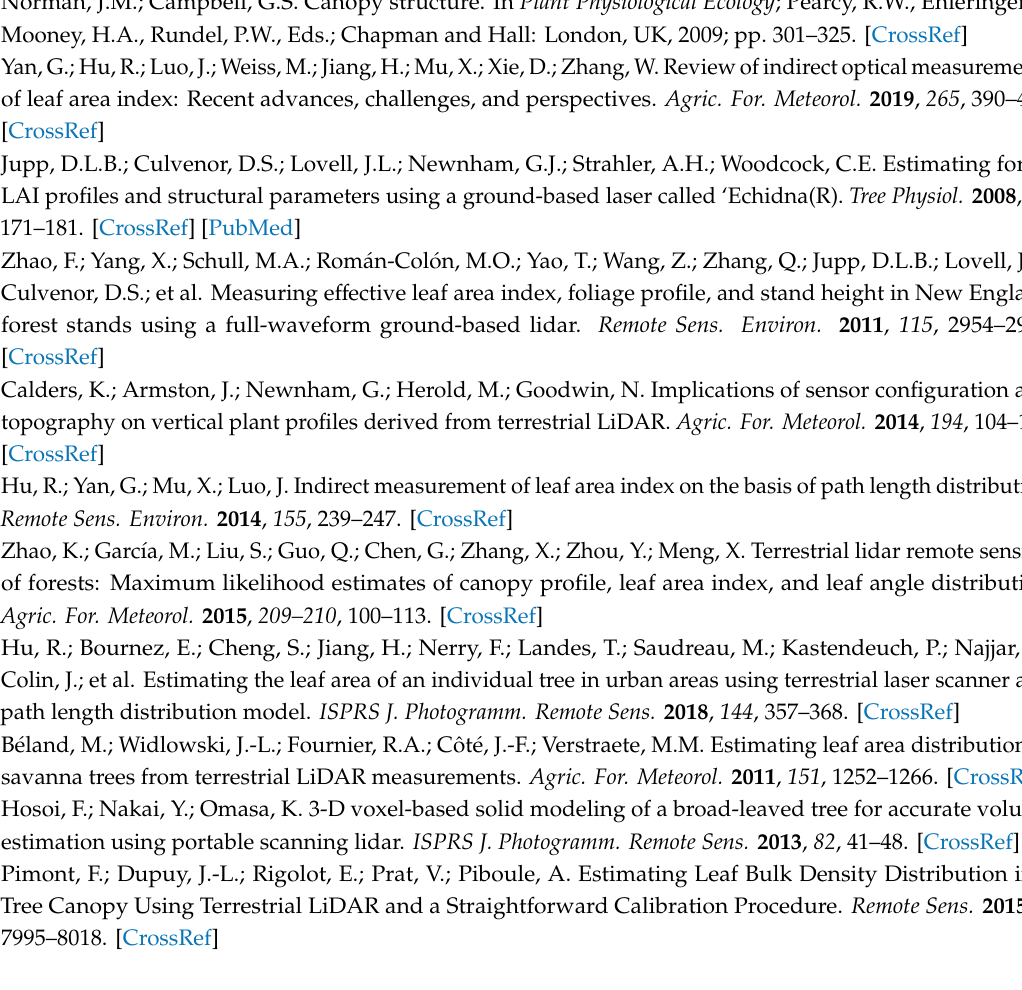
𝑙 in the 200 simulations presented in Section 4.1. Figure A4. Leaf fraction F = Ni l in the 200 simulations presented in Section Ni Ni